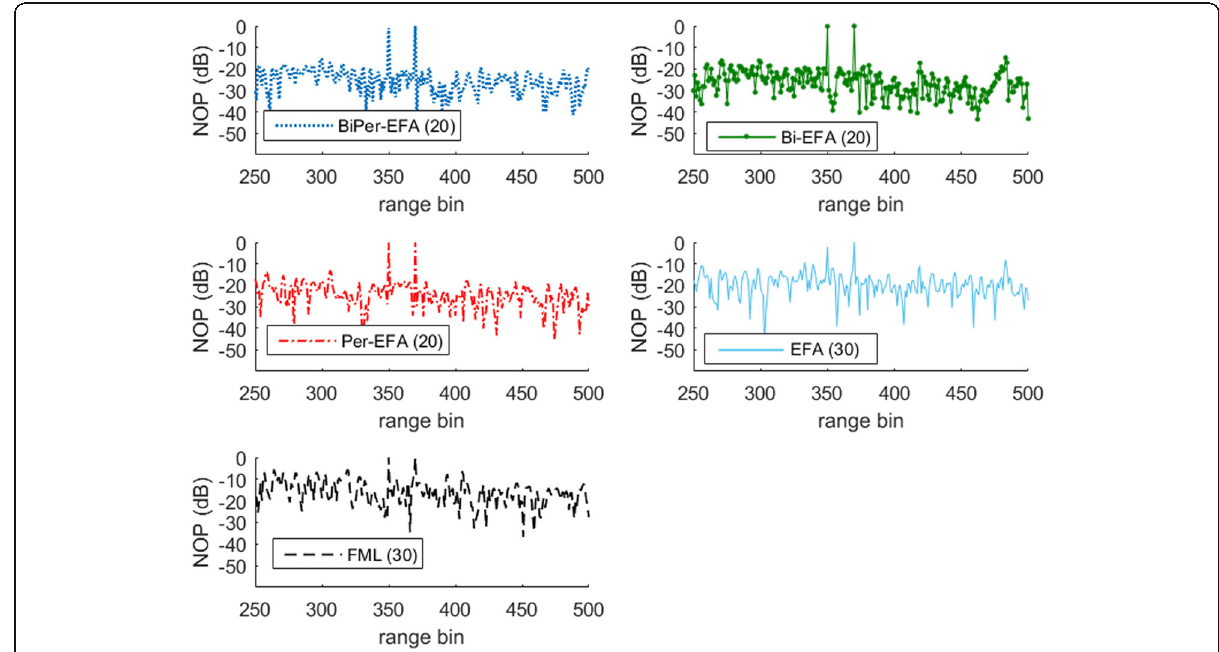
Fig. 11 Curves of NOP against range bins of different